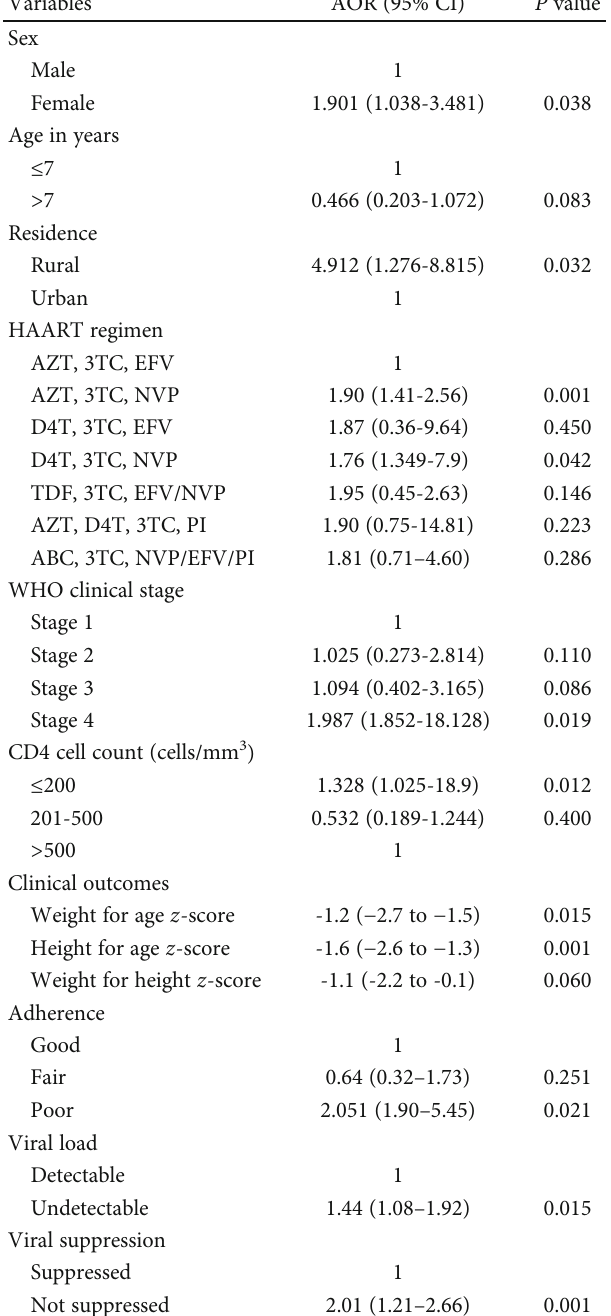
Table 3: Factors a ff ecting viral load suppression and the immunological response among HIV-infected children at Hawassa University ART Clinic ( N = 273